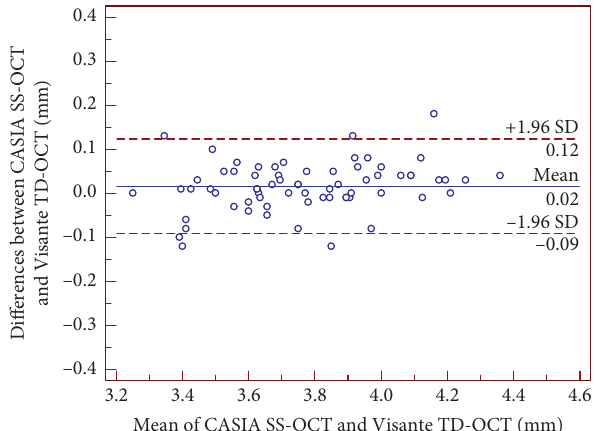
Figure 3: Bland–Altman plot showing the agreement for ACD (from the corneal epithelium to the anterior lens) measurements between the CASIA SS-OCT and the Visante TD-OCT. The solid line indicates the mean difference (bias), and the dotted lines in- dicate 95% limits of agreement